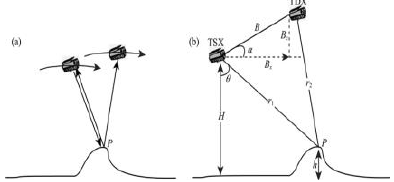
Figure 2. Radar system interference principle